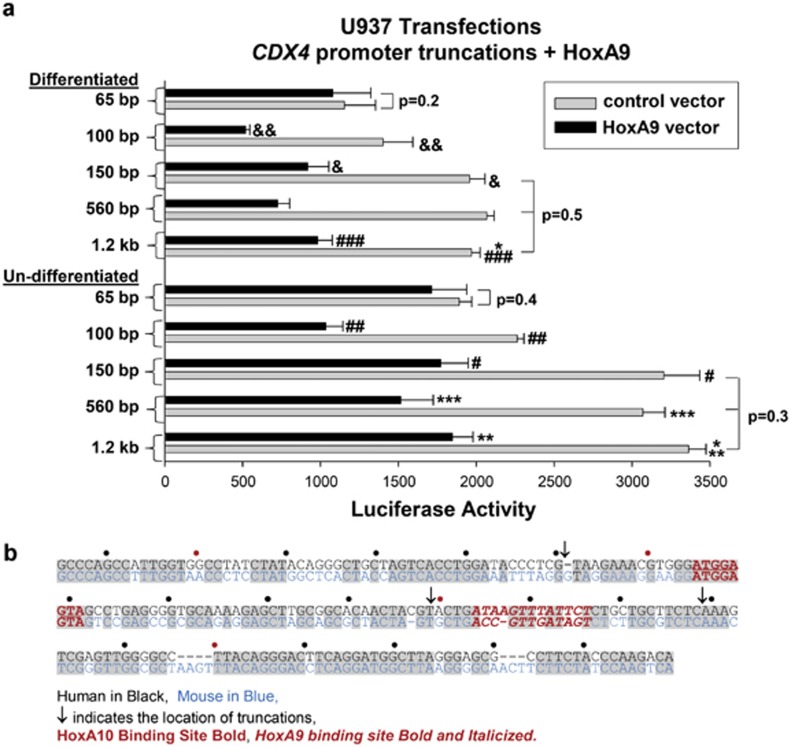
HoxA9 represses CDX4 transcription. (a) HoxA9 decreases CDX4 promoter activity. U937 myeloid cells were transfected with a series of CDX4 promoter–reporter constructs and a vector to overexpress HoxA9 or control expression vector. The reporter activity was determined with or without differentiation with retinoic acid/dimethyl formamide. A statistically significant difference in reporter activity with versus without differentiation is indicated by *. Statistically significant differences in reporter activity with HoxA9 overexpression versus control vector are indicated by **, ***, #, ##, ###, & or &&. Differences with P<0.01 are considered statistically significant. Some nonstatistically significant differences are also indicated. (b) The CDX4 promoter includes multiple Hox DNA-binding consensus sequences. The sequence of the proximal human CDX4 5′ flank (from the transcription start site) is depicted in black and the murine sequence in blue. Conserved sequences are indicated in gray, the distal HoxA10-binding cis element is indicated in red, the proximal HoxA9-binding cis element is indicated in red and italicized and the site of truncations used in reporter assays are indicated by arrows.